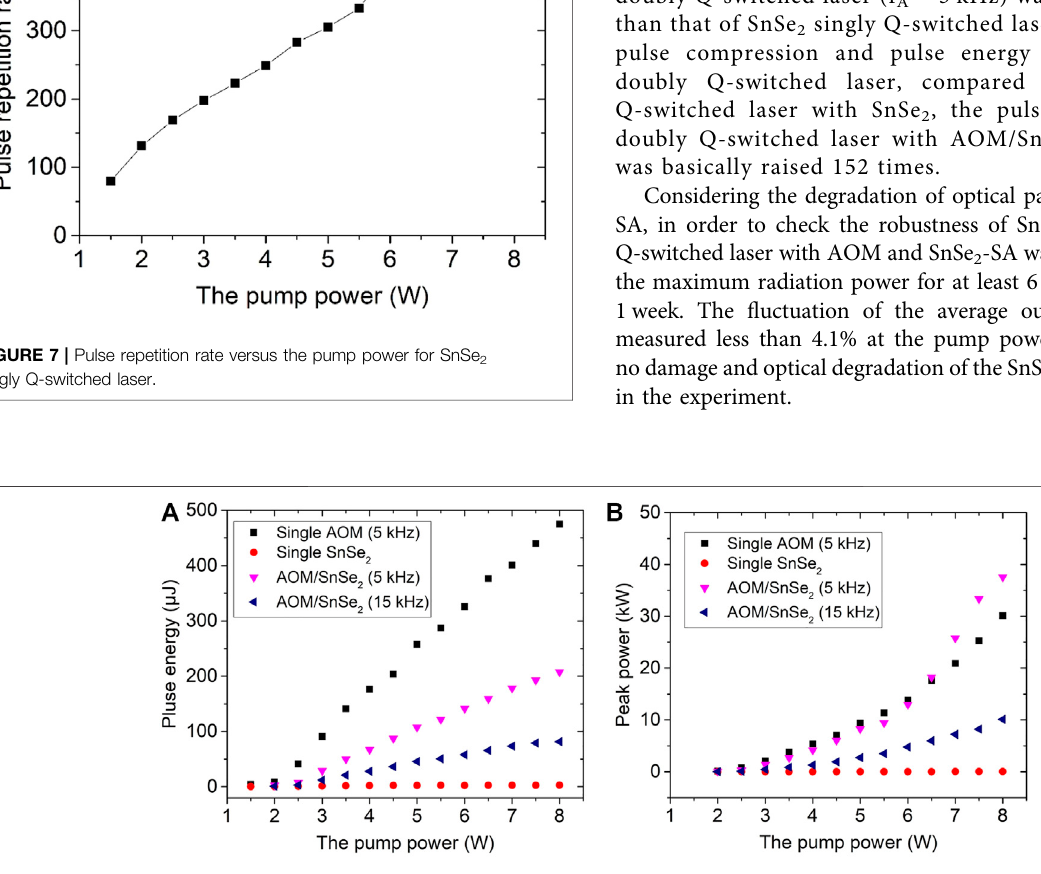
FIGURE 8 | (A) Pulse energy and (B) pulse peak power versus pump power of SnSe 2 singly, AOM singly and AOM/SnSe 2 doubly Q-switched lasers with different f A .